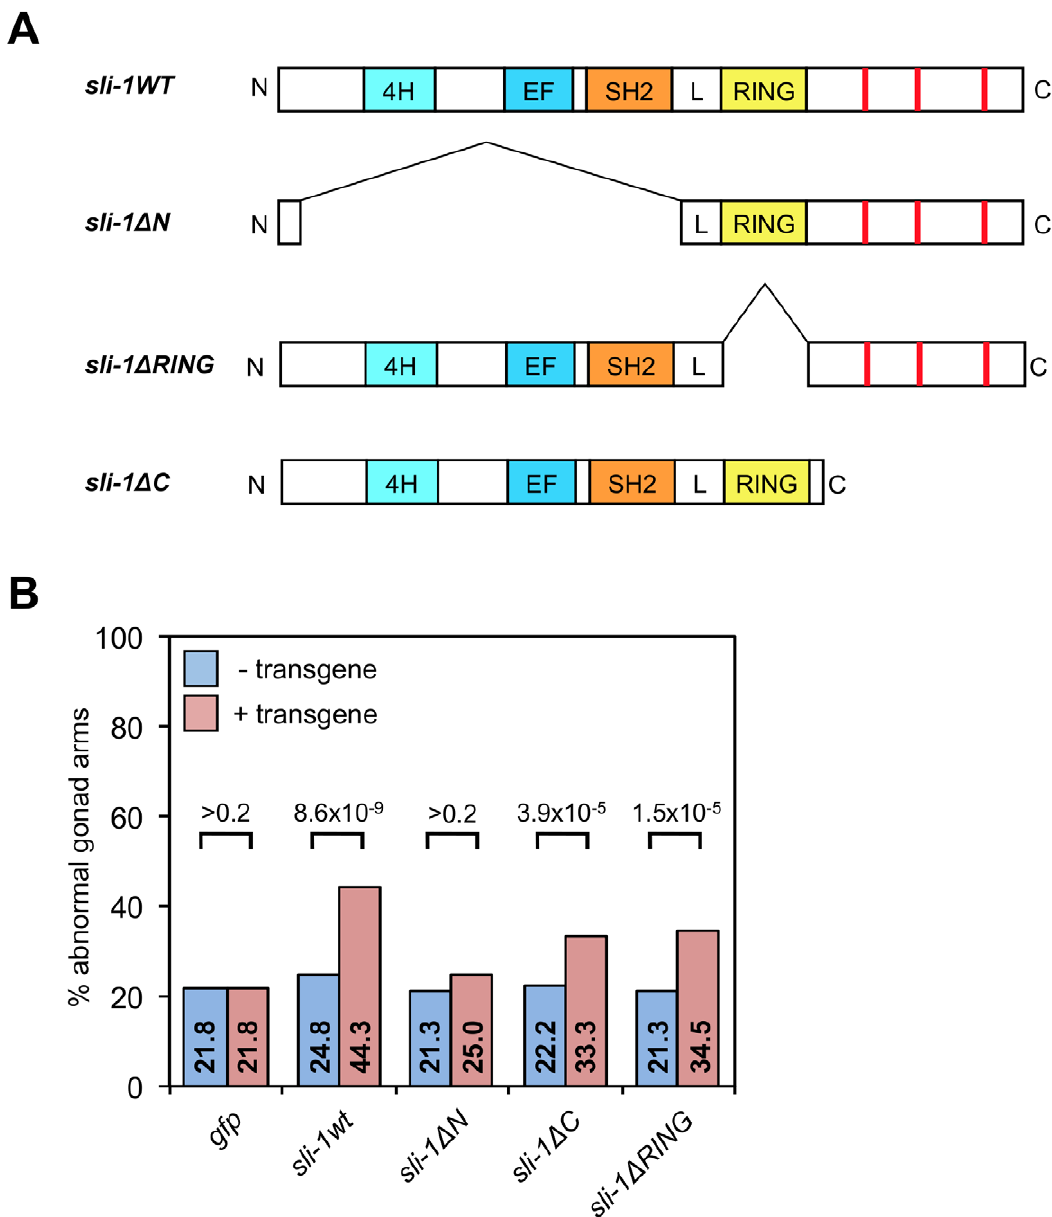
Figure 8. The TKB domain of sli-1 is required for its cell migration function. (A) Truncation minigene sli-1 constructs used in this study. Red lines represent proline-rich areas. L, conserved linker domain between the TKB domain (composed of the 4H, EF hand and SH2 domains) and the RING finger. (B) The gonads of ced-10(n1993); sli-1(sy143) young adult animals with or without transgenic arrays containing the genes shown in (A) were scored for abnormal morphology after heat shock. 200 gonad arms in two independent strains were analyzed per genotype. p values derived using Fisher’s exact test are shown.